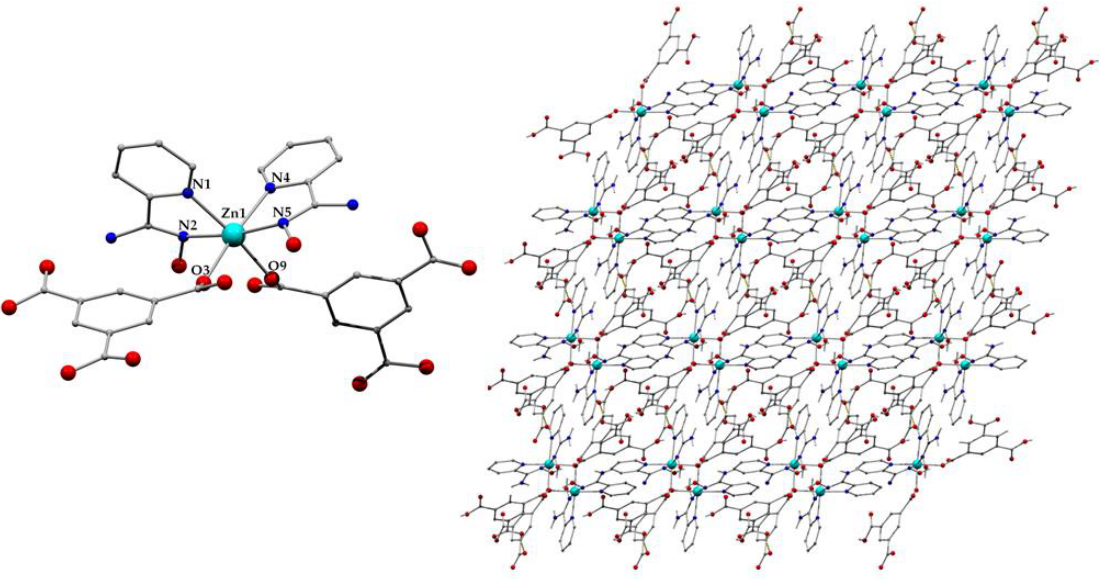
Figure 1. Representation of the molecular structure of compound 1 ( left ) and the 3D network that is formed through intermolecular interactions along c axis ( right ). Colour code: Zn II , cyan; N, blue; O, red; C, grey.